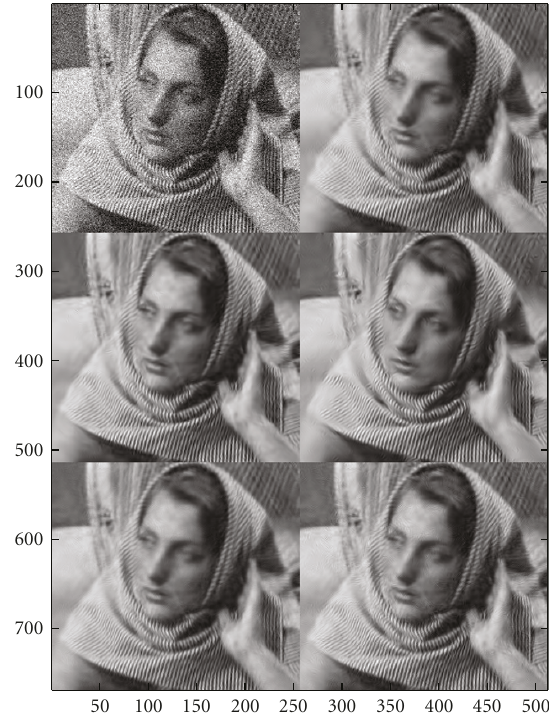
Figure 2: Image denoising results using the Barbara image added with random noise ( σ e = 25). Images shown from top to bottom, left to right are the noisy, results of algorithms in [16, 39, 40], the proposed IGWE-T and GWE2 algorithms. Typical PSNR values for these images are listed in Table